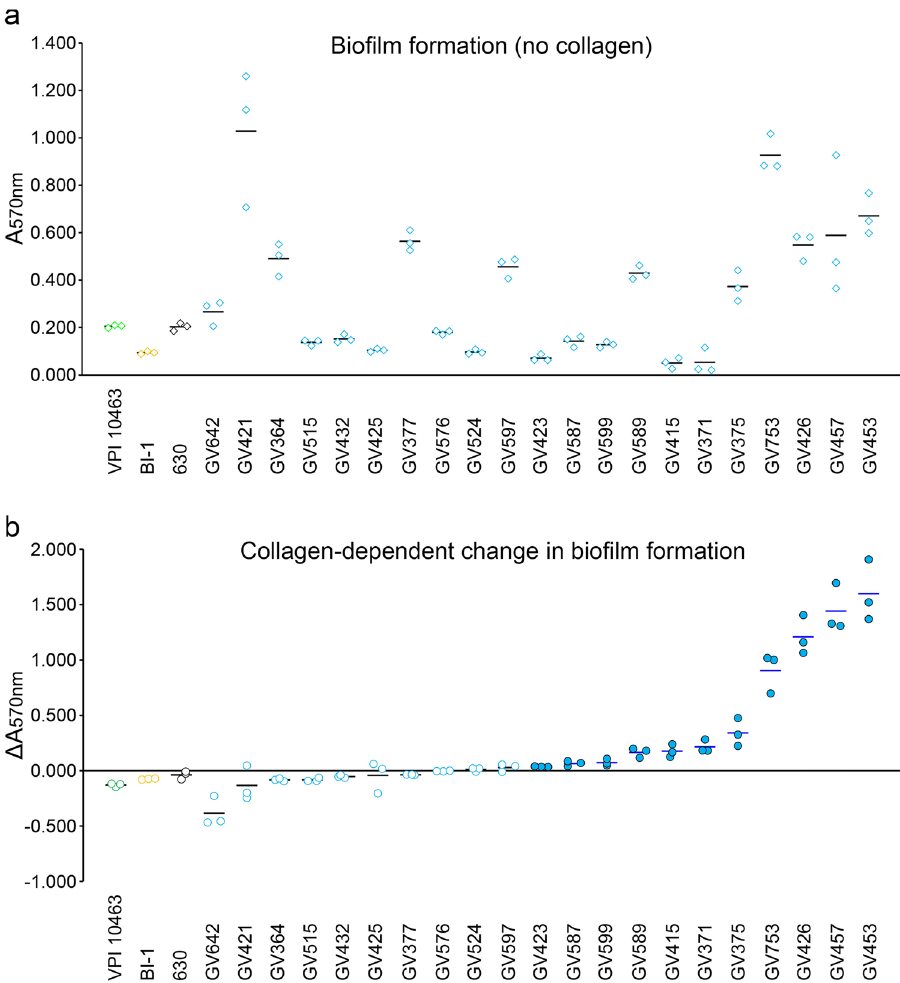
Figure 6. Clinical RT106 isolates display collagen-dependent biofilm formation. ( a ) 21 clinical RT106 strains (blue circles) and 3 non-RT106 toxigenic C. difficile strains (VPI, BI-1, and 630 designated as green, yellow and black circles, respectively) were cultured in uncoated or collagen-coated (combined types I and III) plastic wells for 72 h. RT106 strains displayed variable levels of biofilm on abiotic plastic wells. ( b ) Relative changes in biofilm densities (ΔA 570nm ) were determined by comparing A 570nm of crystal violet-stained biofilms formed on human collagen (combined types I and III) vs. on uncoated plastic wells. Filled blue circles denote P value < 0.05 determined using Student’s t test to compare mean A 570nm by each strain on collagen-coated vs. uncoated wells. No difference in biofilm formation was observed when the reference C. difficile 630, BI-1 and VPI strains were cultured on wells with or without collagen. Overall, RT106 strains displayed denser biofilms on collagen-coated wells (One-sample one-tailed T-test; H alt : mean ΔA 570nm > 0; H 0 : mean ΔA 570nm = 0; P value =